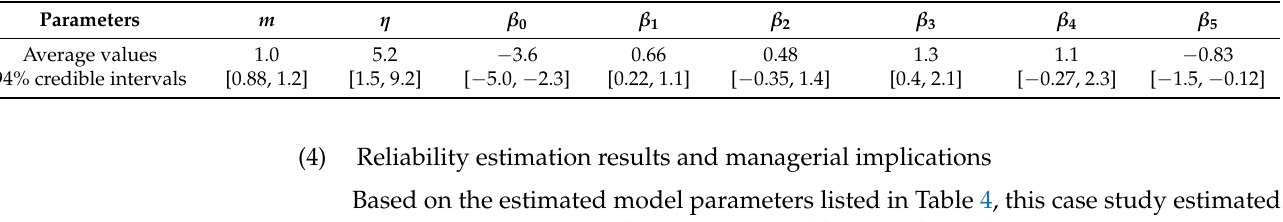
Table 4. Posterior estimates of the model